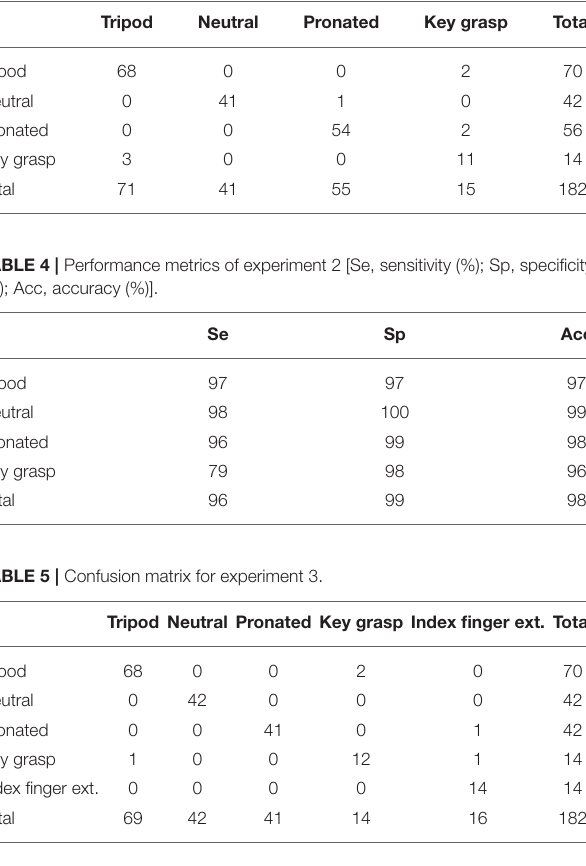
TABLE 3 | Confusion matrix for experiment 2.